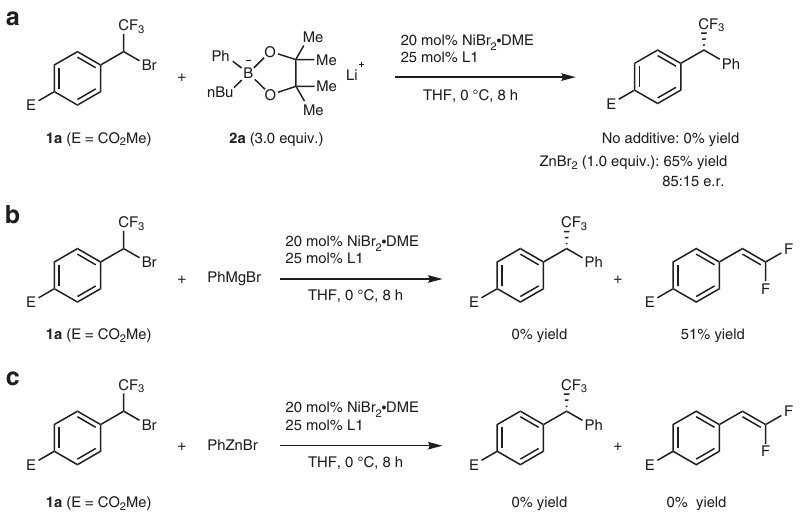
Fig. 2 Ni-catalyzed asymmetric cross-coupling reaction with different nucleophiles. a Coupling with lithium phenyl boronate. b Coupling with Grignard reagent. c Coupling with aryl zinc halide Table 1 Optimization of the reaction conditions